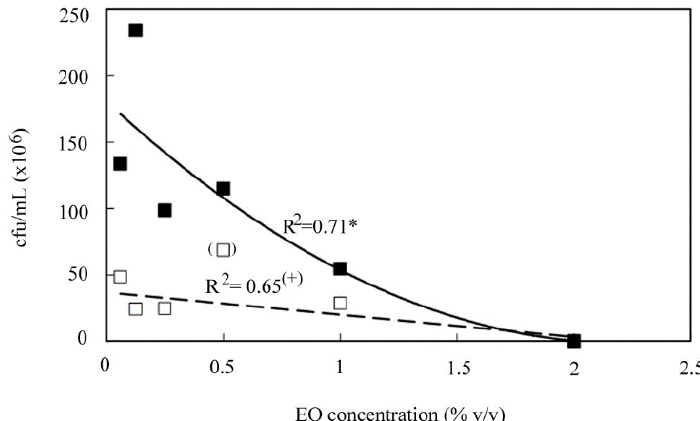
Figure 1. cfu / ml of Saccharomyces cerevisiae (filled symbol) and Candida albicans (empty symbol) in response to Citrus aurantium var. amara essential oil (EO) concentration. Solid line, exponential decay function (Equation (2)) describing S. cerevisiae abatement at increasing EO concentration. Dashed line, linear function (Equation (1)) describing C. albicans abatement at increasing EO concentration. ( + ) and *, significant at p ≤ 0.10 and p ≤ 0.05, respectively.